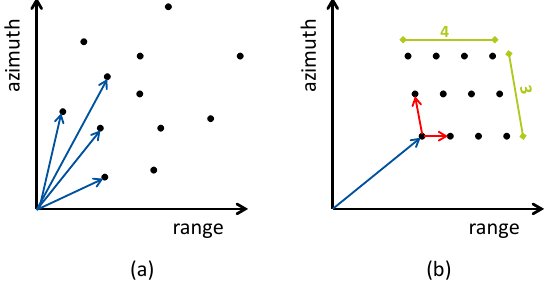
Figure 4: The MDL principle to evaluate the grouping of PS. (a) 12 randomly distributed PS. The proposed model simply stores all 12 two-dimensional coordinates. (b) 12 PS aligned in a lattice structure. The more sophisticated model describes the PS by the lattice’ origin (blue), two spanning vectors (red) and two replica- tion vectors (green) which define the size of the